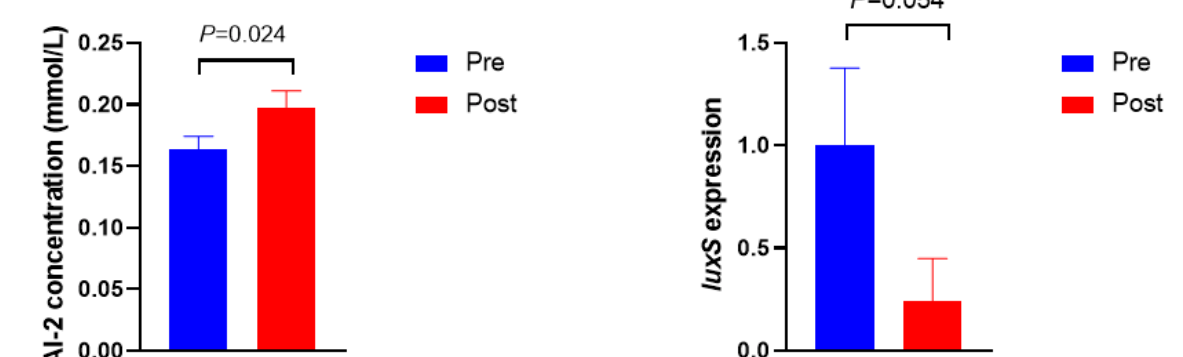
Figure 2. AI-2 concentration and luxS gene expression before (Pre) and after (Post) diet shift.